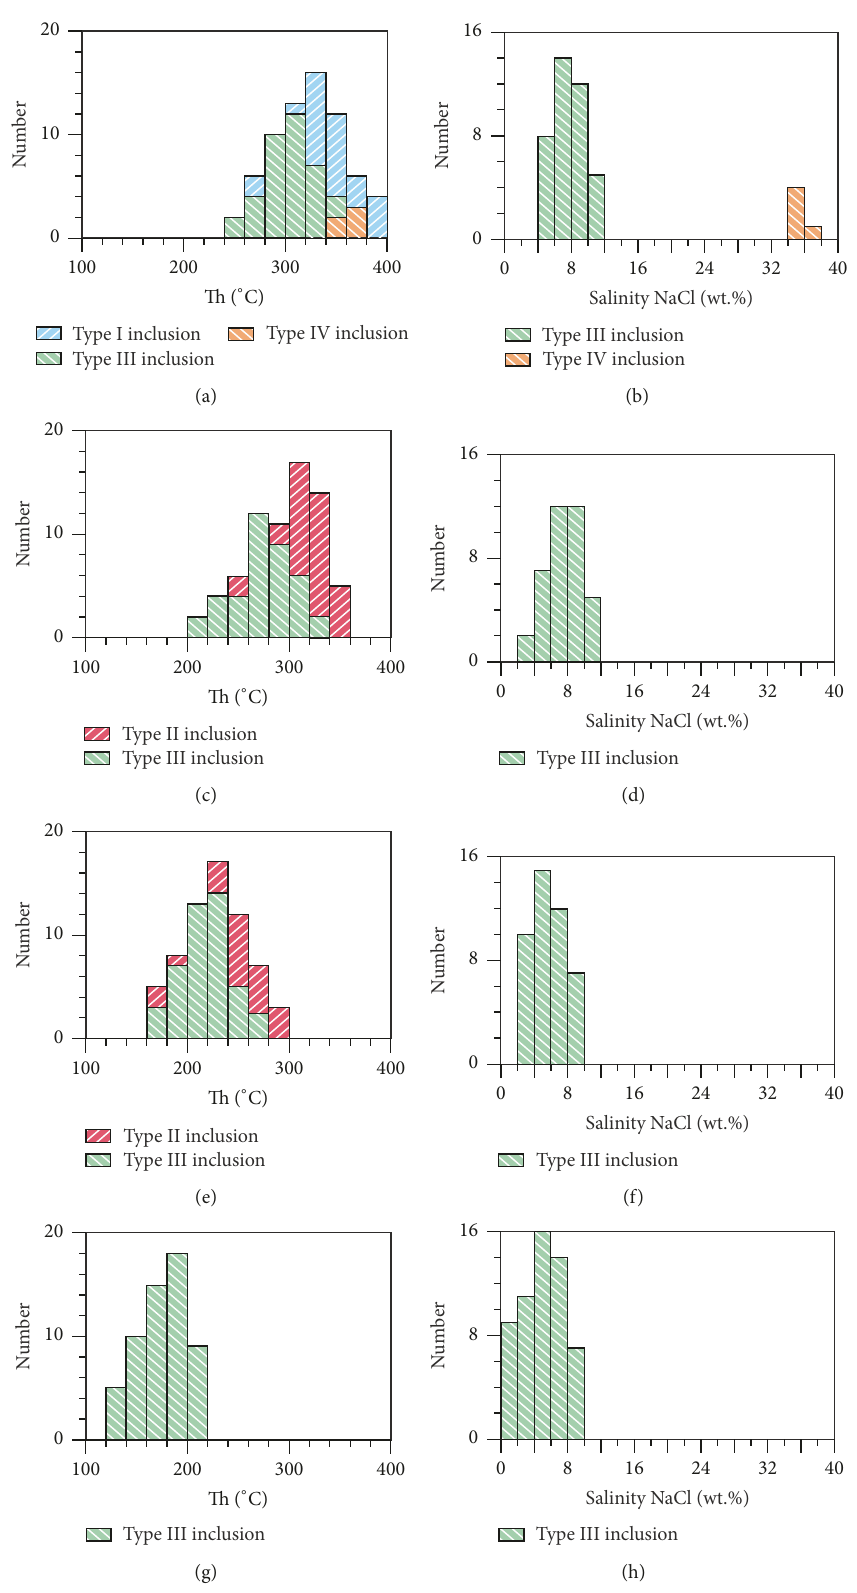
Figure 6: Histograms of microthermometric data for fluid inclusions in hydrothermal quartz and fluorite of the Bairendaba Ag-Zn- Pb deposit. (a) Homogenization temperatures for Types Ι , III, and Ι V; Stage 1 quartz. (b) Salinity for Types III and Ι V; Stage 1 quartz. (c) Homogenization temperatures for Types ΙΙ and III; Stage 2 - 1 quartz. (d) Salinity for Type III; Stage 2 - 1 quartz. (e) Homogenization temperatures for Types ΙΙ and III; Stage 2 - 2 quartz. (f) Salinity for Type III; Stage 2 - 2 quartz. (g) Homogenization temperatures for Type III; Stage 3 fluorite. (h) Salinity for Type III; Stage 3